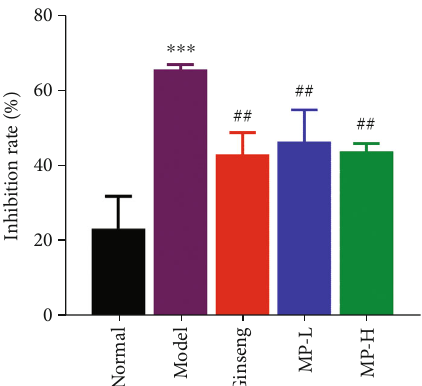
Figure 7: E ff ects of Maca polysaccharides on spleen lymphocyte inhibition rate ( n = 12 ); ∗∗∗ p < 0 : 001 vs. control group; ## p < 0 : 01 vs. model